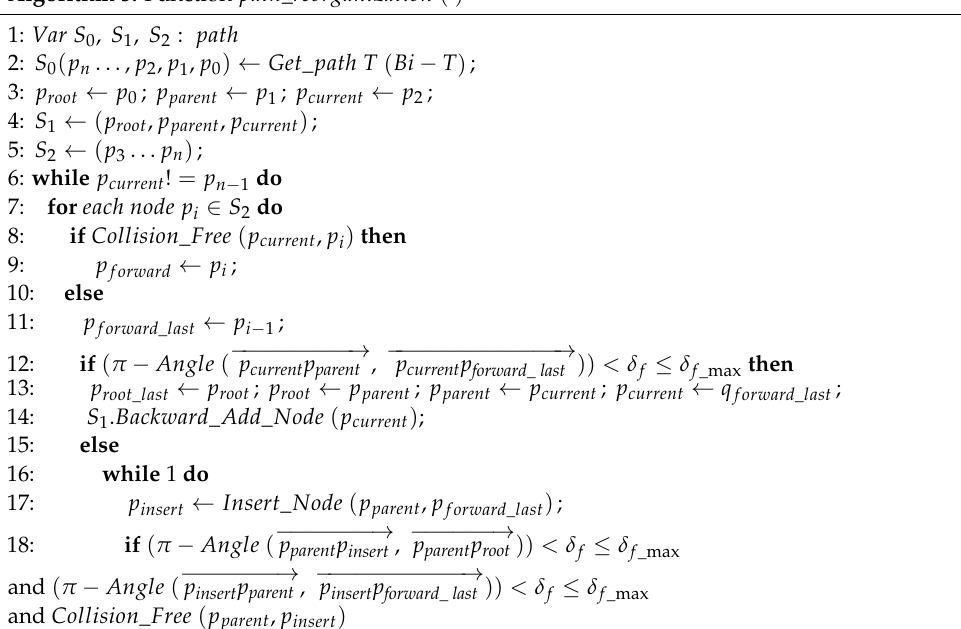
Algorithm 5: Function path _ reorganization (